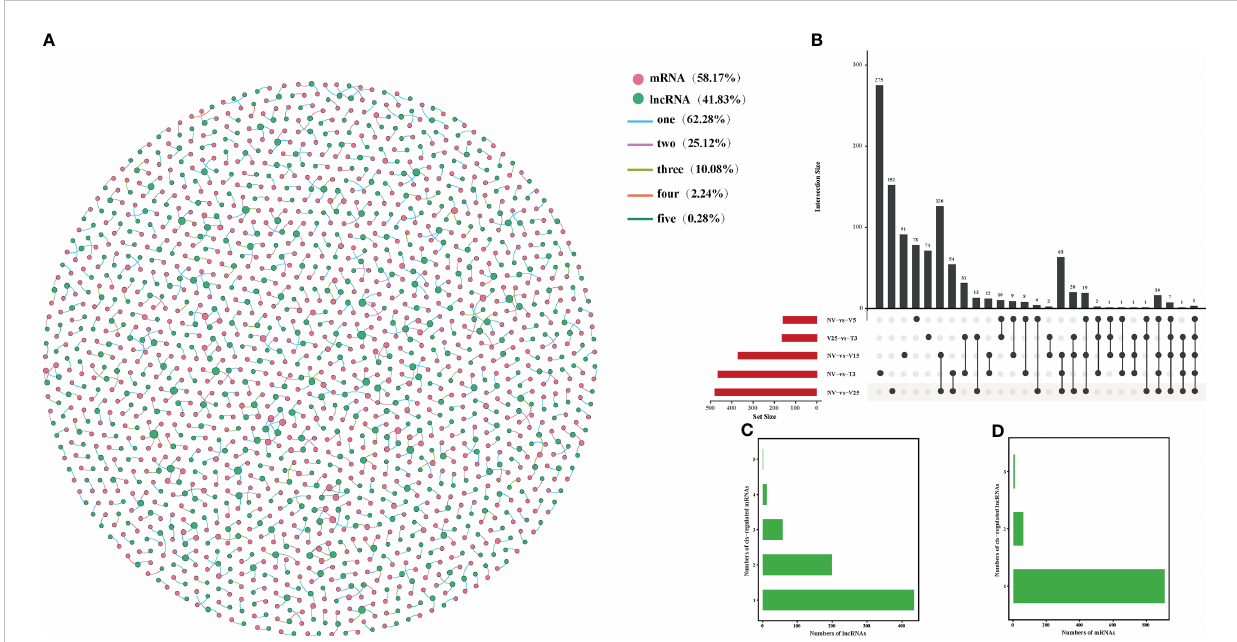
FIGURE 5 Interactions between DE lncRNAs and cis-regulated DE mRNAs during plumule-vernalization in Chinese cabbage. (A) The DE lncRNA – mRNA interaction network of fi ve comparisons (NV-vs-V5, NV-vs-V15, NV-vs-V25, NV-vs-T3, and V5-vs-T3). The nodes represent the mRNAs (red) and lncRNAs (green). The size of the node is positively related to the number of mRNAs (lncRNAs) associated with lncRNAs (mRNAs). The color of the line indicates that a relationship exists in several comparison groups (1/2/3/4/5). (B) Venn diagram showing the number of matched lncRNA – mRNA pairs in different comparisons. (C) The number of DE mRNAs regulated by DE lncRNAs. (D) The number of DE lncRNAs that have potential cis- regulatory effects on DE